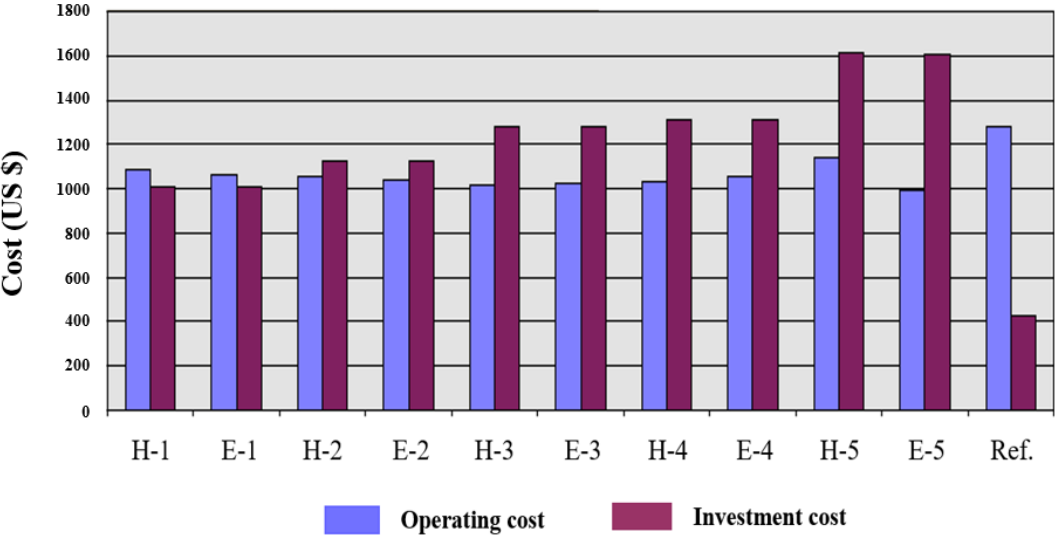
Figure 9. Comparison of the simulated operational cost – benefit in Case A.